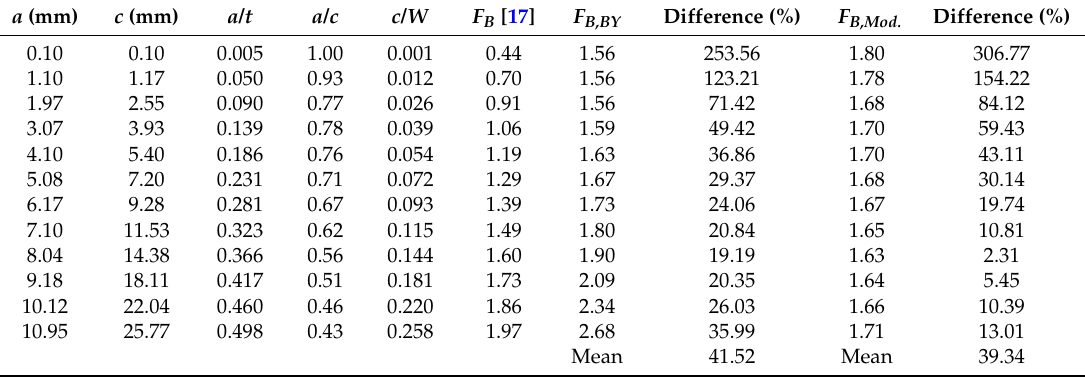
Table 4. Comparison of the dimensionless stress intensity factor values from the Baik-Yamada formula, the modified formula and the literature results by the wavelet and extended finite elememt method at point B .